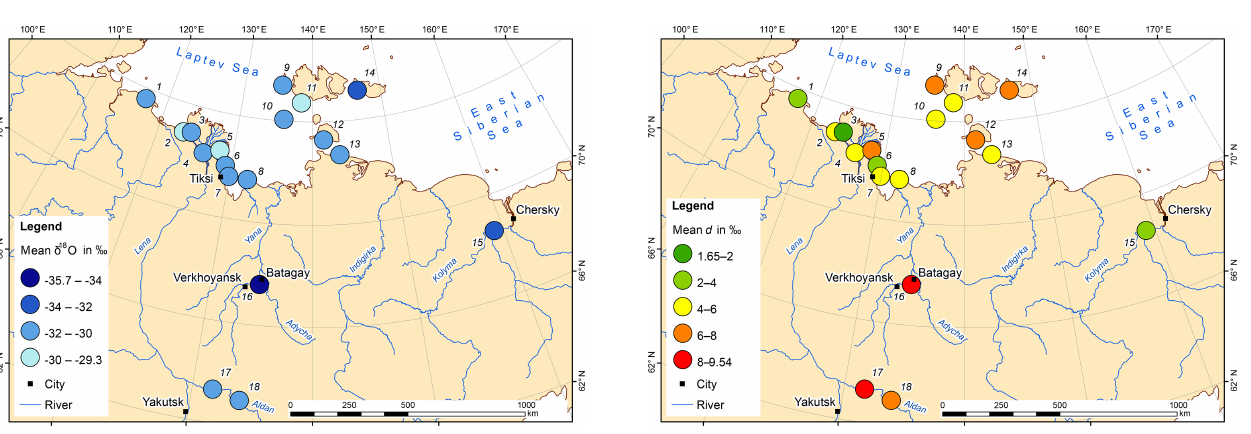
Figure 8. Map of mean δ 18 O data from Siberian ice wedges at- tributed to the MIS 3 interstadial (about 50 to 30kyr). Site IDs are given in Fig. 7 and further details in Table S3.